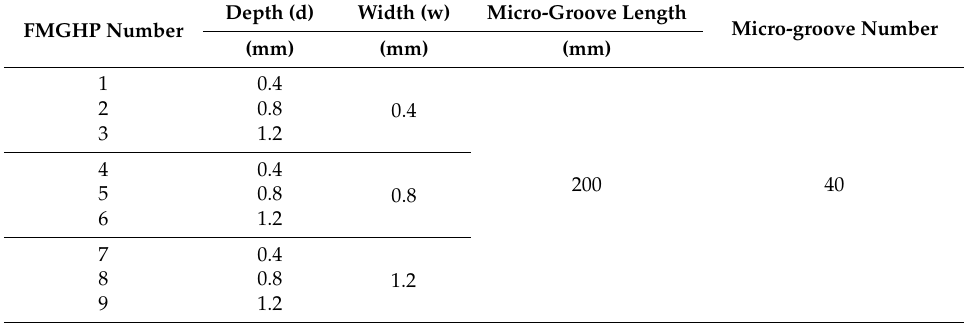
Table 1. The nine kinds of dimensions of rectangular micro-grooves.